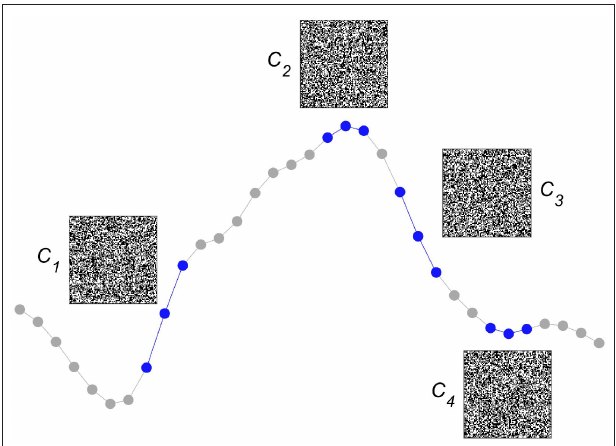
FIGURE 2 | Encoding local intracranial electroencephalogram (iEEG) order relations into hyperdimensional (HD) vectors. We consider whether an iEEG sampling point is ≥ or (cid:3) than its preceding one. The simple situation of only three sequential iEEG sampling points, used here to demonstrate the method, yields four different possible pairs of order relations (plotted in blue), each of which is associated with a unique quasi-orthogonal binary HD vector of dimension D = 10,000. For ease of graphical display, the HD vectors of size 1 x 10,000 are reshaped into squares of size 100 × 100. Each quasi-orthogonal HD vector represents a unique relation, e.g., C 1 represents the relation ( ≥ , ≥ ), C 2 ( ≥ , (cid:3) ), C 3 ( (cid:3) , (cid:3) ), and C 4 ( (cid:3) , ≥ ). These HD vectors are stored in the item memory and stay unchanged during both learning and